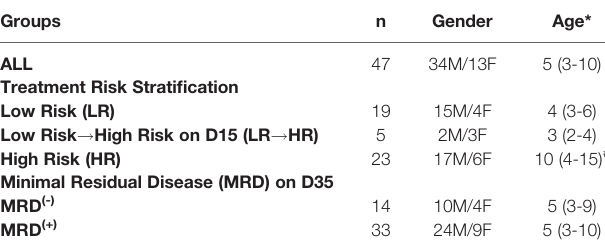
TABLE 1 | Demographical and clinical features of the study